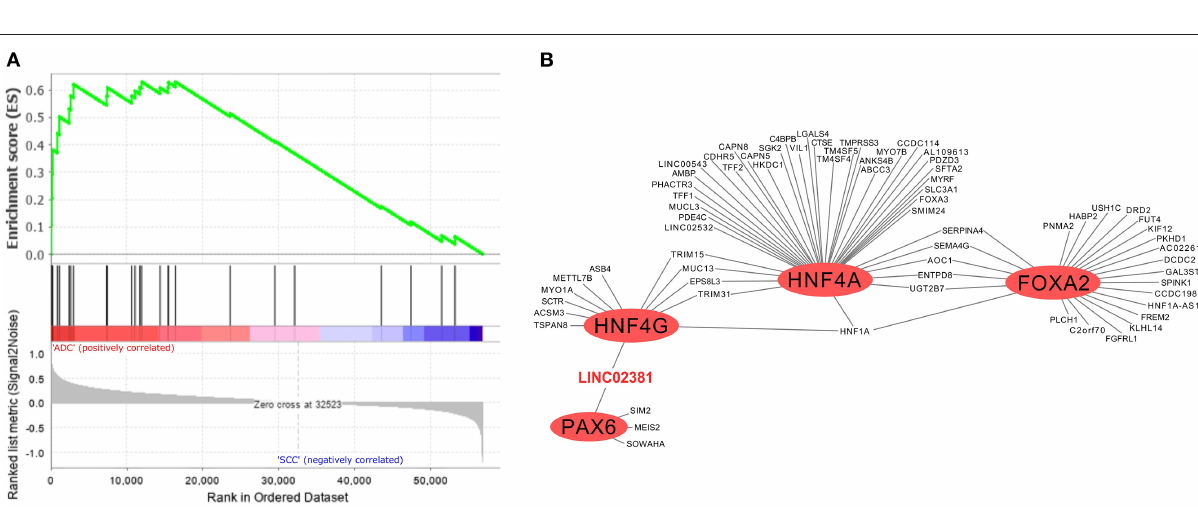
Frontiers in Oncology |